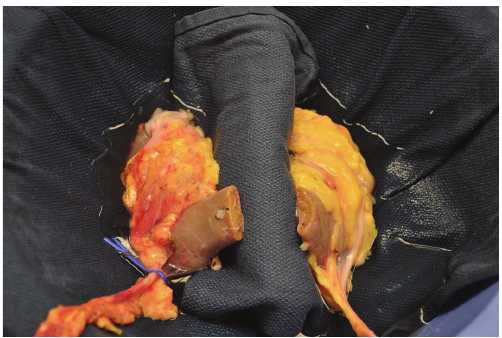
Figure 2: Divided kidneys. The cut ends were oversewn with pledgeted no. 1 Vicryl sutures in preparation for transplantation of the two kidneys into recipient patients.